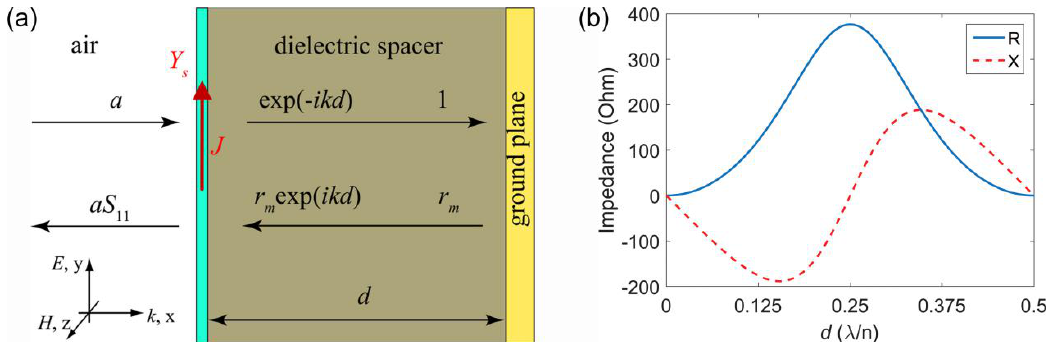
Figure 2. ( a ) Schematic illustration of the absorption structure which comprises a ultra-thin sheet, dielectric spacer and metallic ground plane. The amplitude of E field of forward going wave at the ground plane is chosen to be 1 while the amplitude of incident E field is denoted as a . ( b ) The resistance ( R ) and reactance ( X ) of the impedance for PIMS as a function of the dielectric spacer thickness. Reproduced from reference [79], with permission from Optical Society of America,